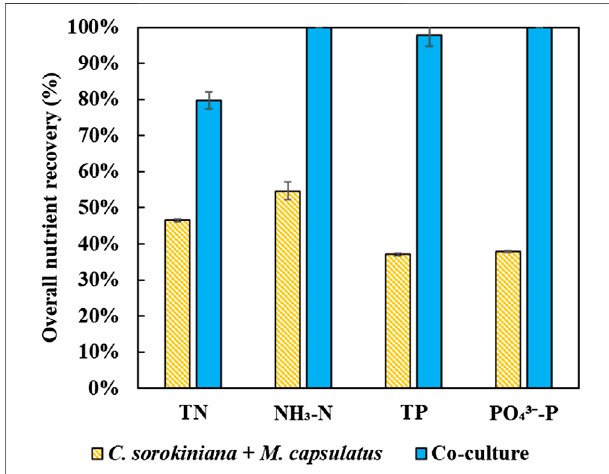
FIGURE12| Percentnutrientrecoverybythecoculturecomparedtothe sum of the single cultures.